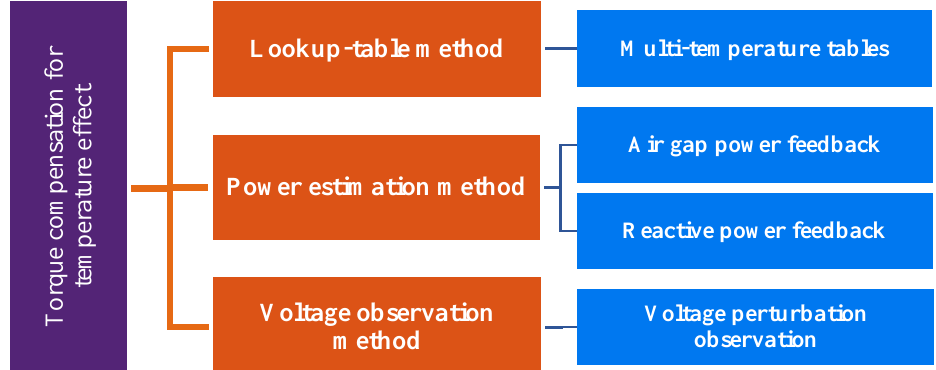
Figure 1. Summary of algorithms for torque deviation caused by temperature change.